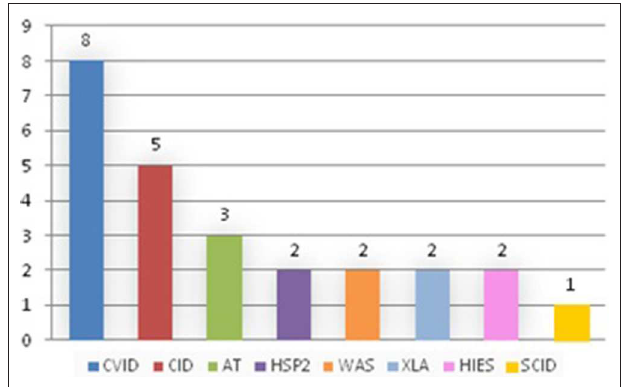
FIGURE 1 | Patients with